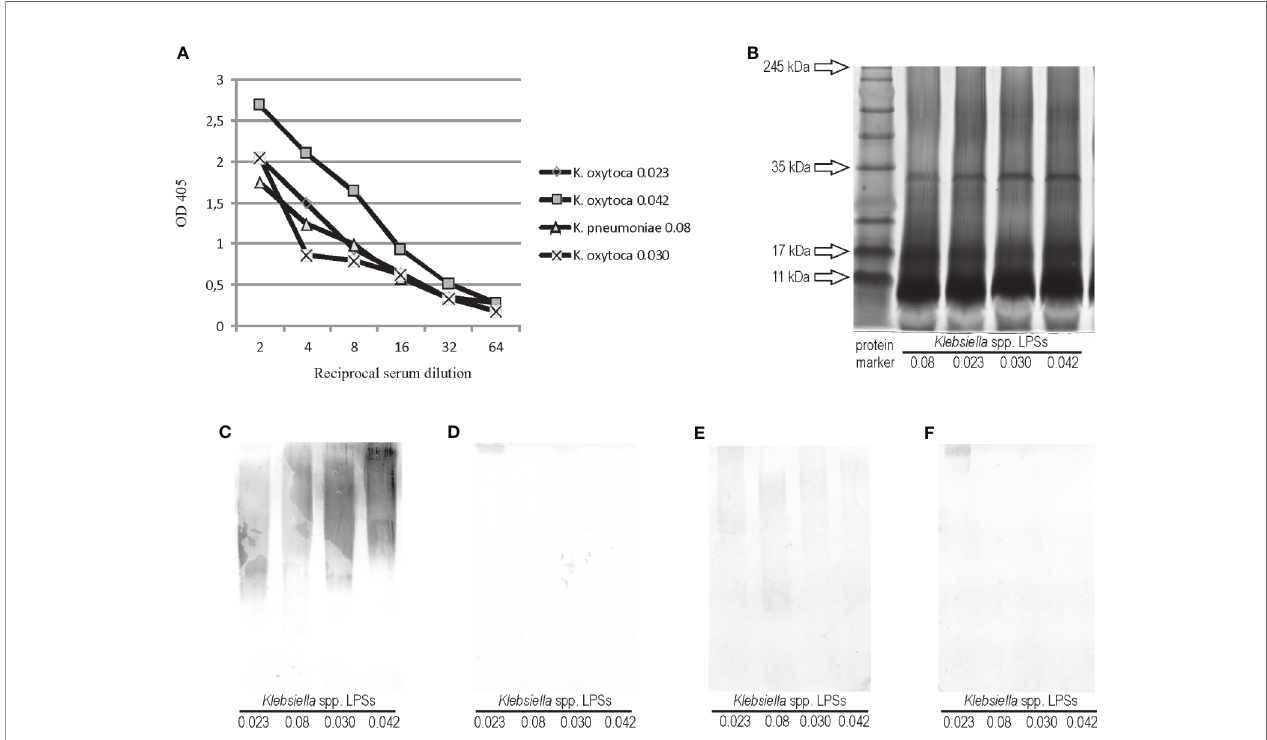
FIGURE 2 | (A) Reactivity of K. oxytoca 0.023 serum with Klebsiella spp. tested LPSs in ELISA. (B) SDS-PAGE and Alcian blue-silver staining procedures obtained for Klebsiella spp. LPSs tested. Lane 1 shows prestained protein marker; Western blotting reactions of (C) K. oxytoca 0.023 unadsorbed serum (control), (D) K . oxytoca 0.023 serum adsorbed by the K. pneumoniae 0.08 cells, (E) K. oxytoca 0.023 serum adsorbed by the K. pneumoniae 0.042 cells, and (F) K. oxytoca 0.023 serum adsorbed by the K. pneumoniae 0.030 cells with Klebsiella spp.-tested